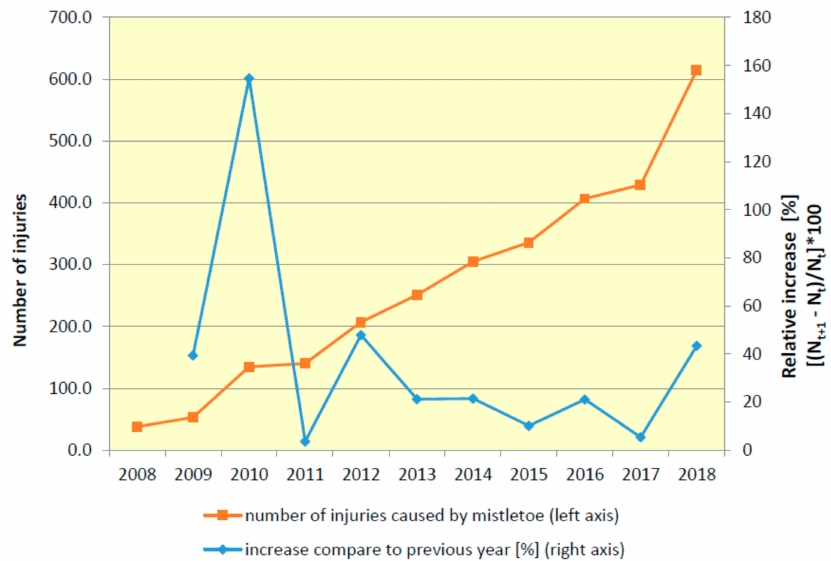
Figure 2. Number of injuries caused by mistletoe and its relative increase in the period 2008–2018. For these years the increases were close to or exceeded 50% of the number of mistletoe counts of the previous year. Significant and rapid increase in the number of injuries caused by V . album in the period 2008–2018 was accompanied by a similar increase of number of plots with trees a ff ected by the parasite. In 2008 the mistletoe was present on just 18 level 1 plots located mostly in the western part of the country, while in 2018 it was found on 179 plots distributed over a much greater area, covering a zone in the central lowland part of Poland from the west to the east and accompanied by secluded plots with the parasite located mainly in Eastern Poland (Figure 3).